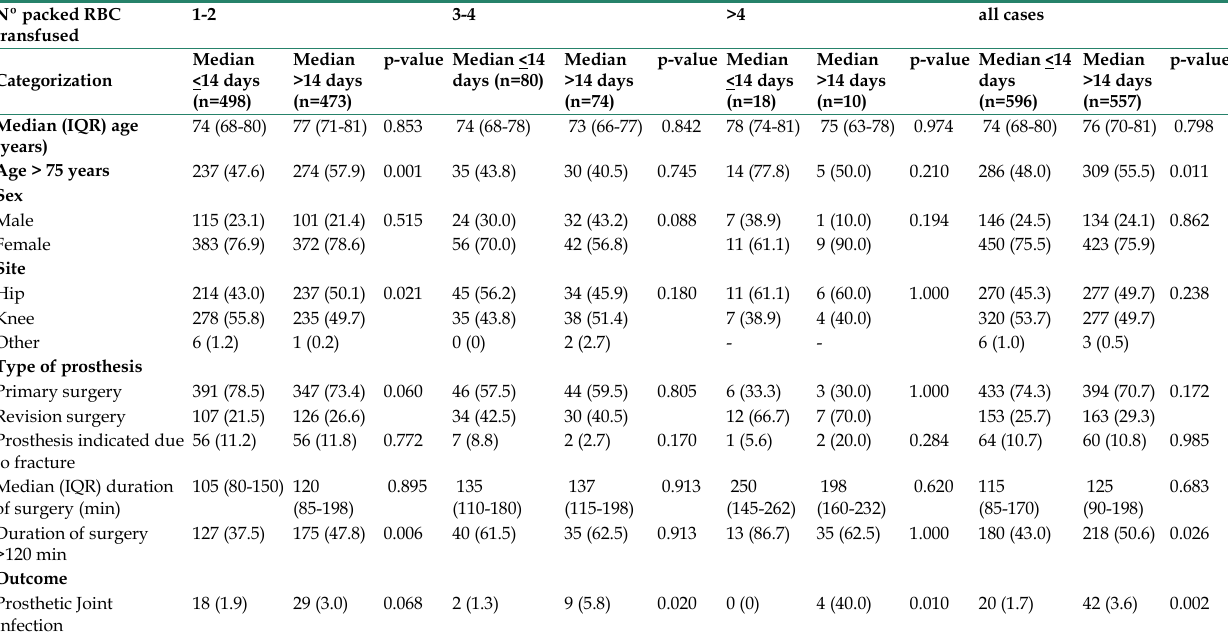
Table 2. Baseline characteristics of patients receiving a blood transfusion during surgery or within the first 6 hours after surgery according to the number of red blood cells (RBC) units transfused and the number of RBC units stored more than 14 days. Nº packed RBC transfused